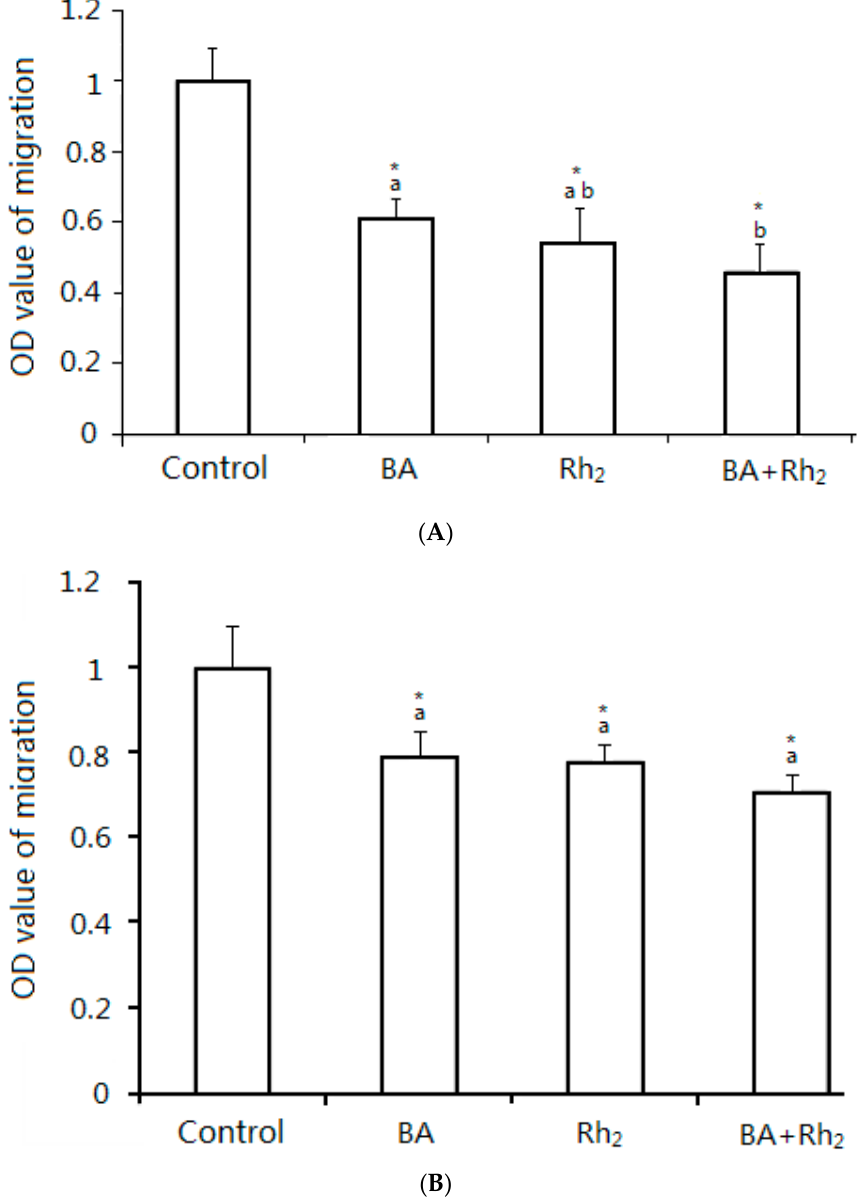
Figure 3. In the trans-well chamber assay, MDA ( A ) and MCF-7 ( B ) cells were treated with vehicle control, EC 50 values of BA, Rh 2 and BA with Rh 2 for 48 h. Cells suspended in serum-free media were seeded on the upper membrane of the trans-well chamber and incubated for 48 h. Complete growth medium was added on the bottom. Cells on the lower membrane of the chambers were counted. Data are presented as mean ± SD. An asterisk (*) indicates a significant difference from the control ( p < 0.05). * Compared to the control, p < 0.05. Different letters showed significant difference in sample groups ( p < 0.05).